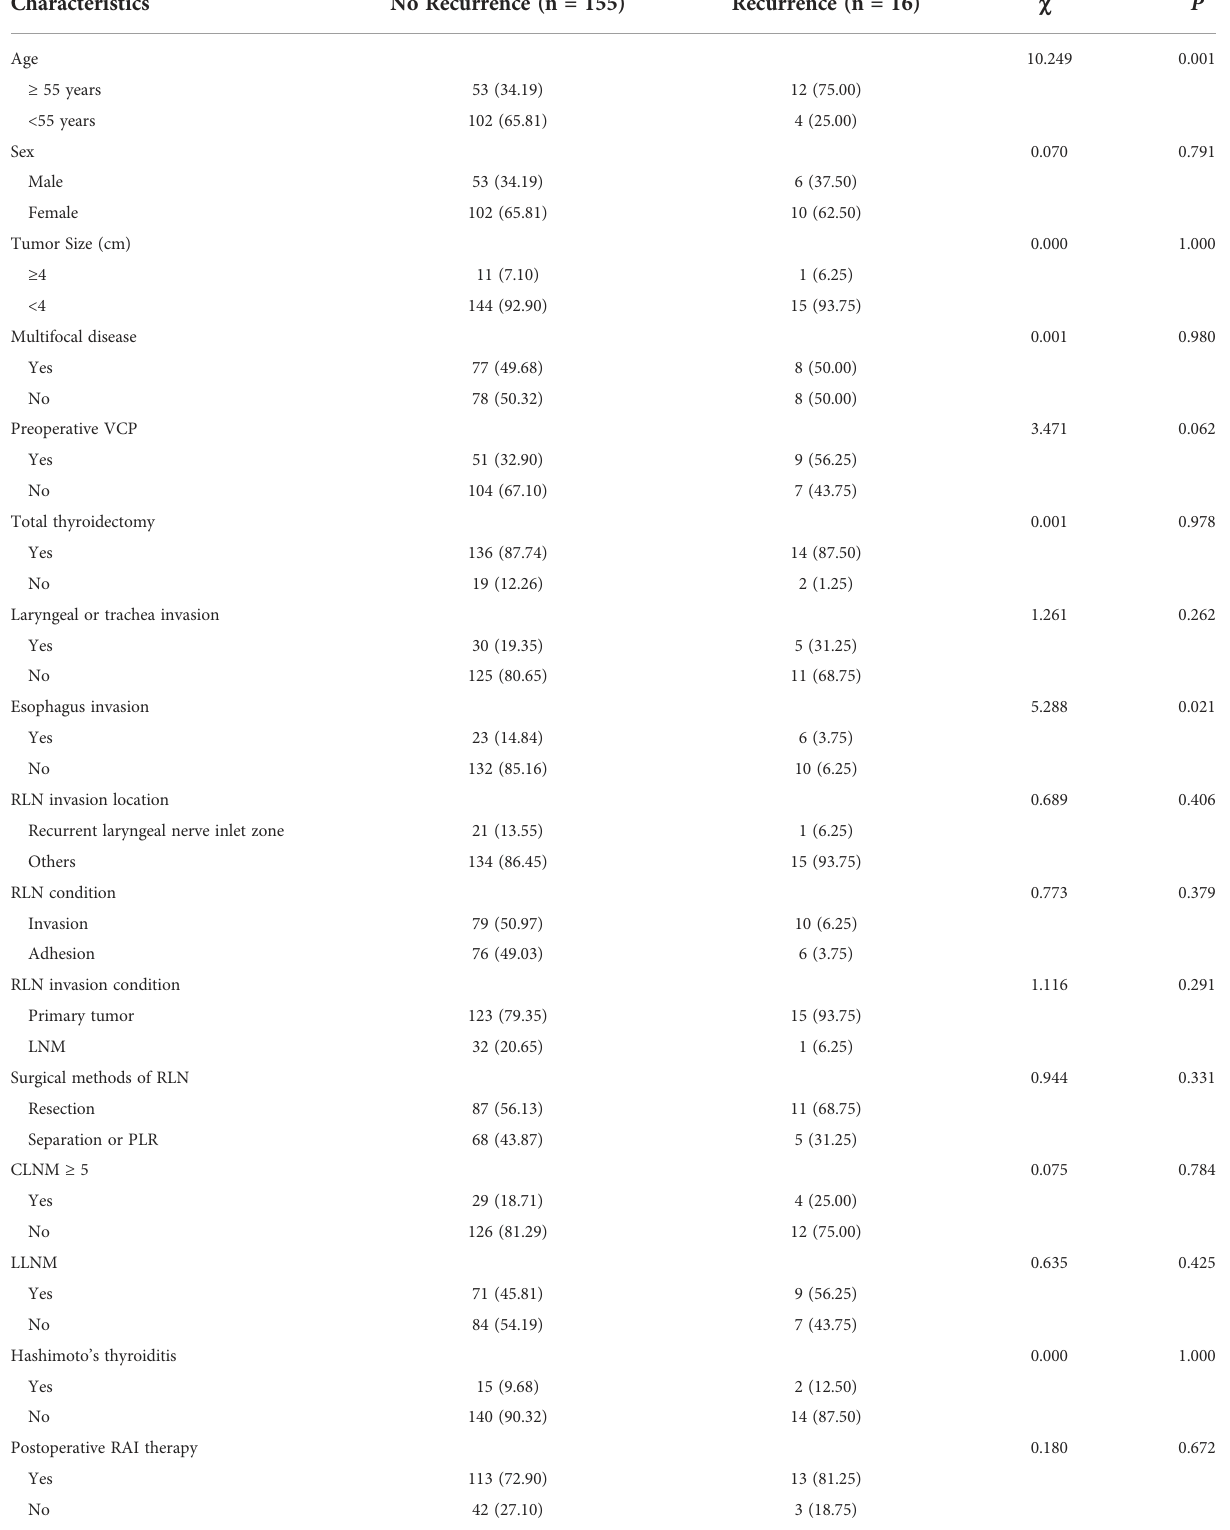
TABLE 4 Association between clinicopathological characteristics and recurrence in PTC patients with RLN invasion (n, %).